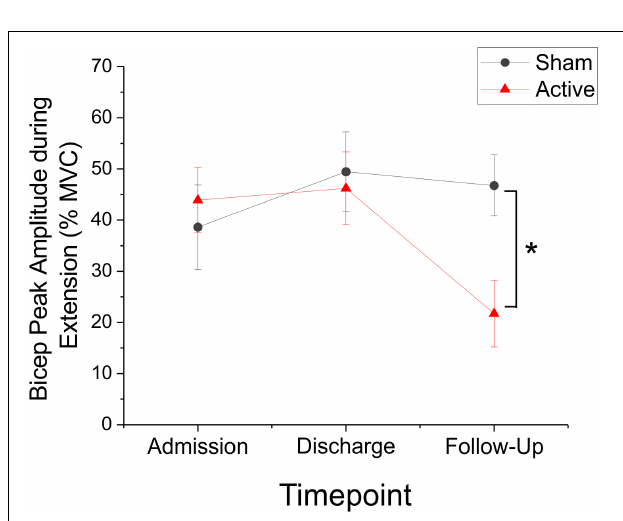
FIGURE 5 | Bicep Peak amplitude (as represented by% mean voluntary contraction ± SEM) decreased significantly during extension movements in the active taVNS group ( N = 14), but not the sham group ( N = 14) at follow-up (Friedman RM-ANOVA, sham: P = 0.931; active: P < 0.05, Chi-square = 7.0). Post hoc pairwise comparisons showed a significant reduction in bicep peak RMS amplitude between discharge and follow-up for the active taVNS group (Tukey test, * P < 0.05). There were no significant between-groups differences.